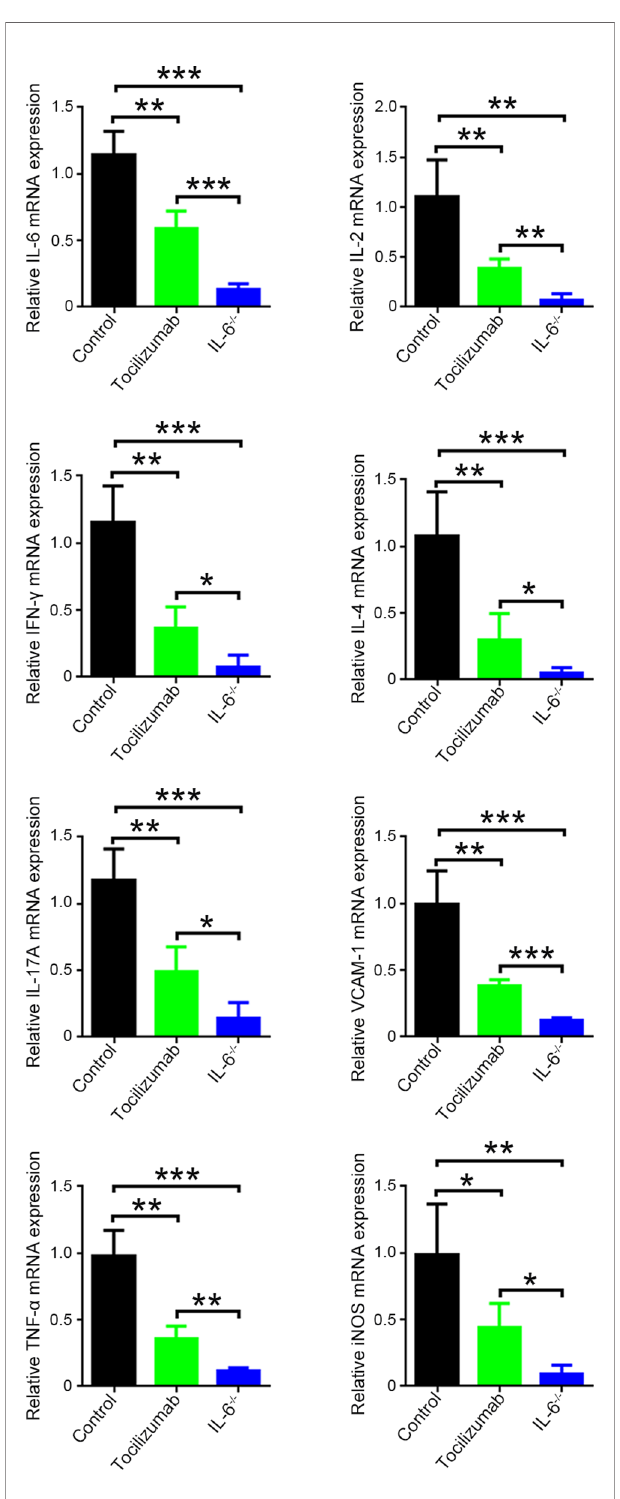
FIGURE 7 | mRNA expression levels of pro-in fl ammatory cytokines in cardiac allografts. The mRNA expression of IL-6 , IL-2 , IFN- g , IL-4 , IL-17A , VCAM-1 , TNF- a , and iNOS in cardiac allografts 4 d post-transplantation in the control, tocilizumab, and IL-6 -/- groups (n = 4/group). *P<0.05; **P<0.01;